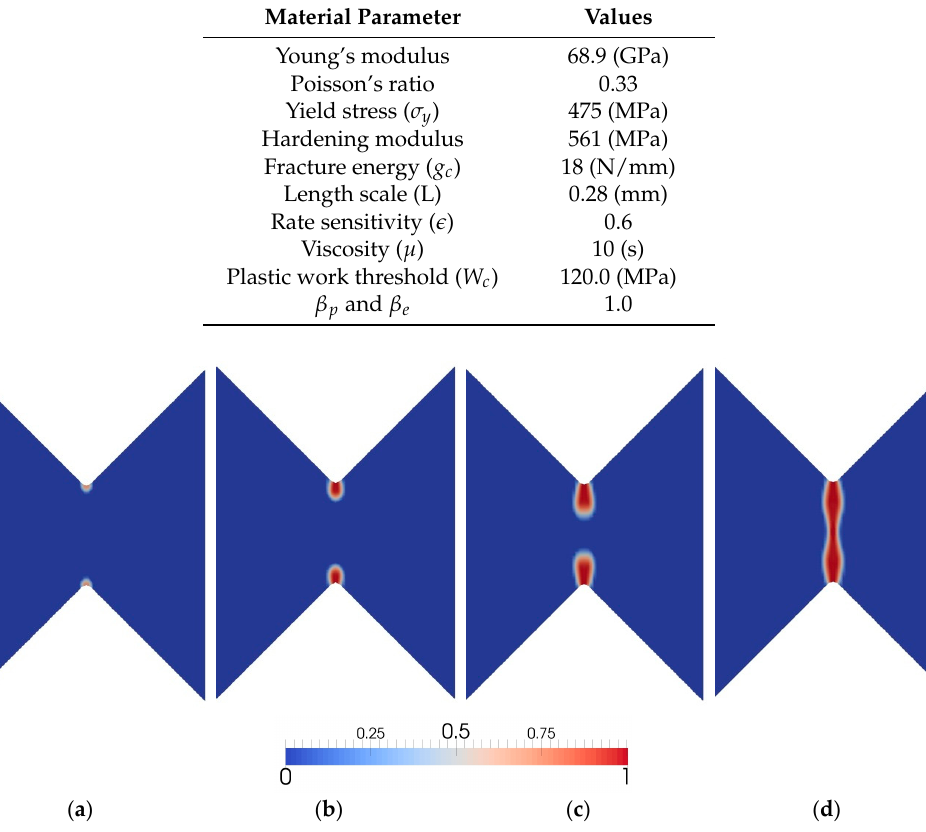
Figure 4. Contours of the phase field variable on V ‐ notched sample at different loading stages: ( a ) 0.37 mm; ( b ) 0.41 mm; ( c ) 0.47 mm; and ( d ) 0.6 mm.